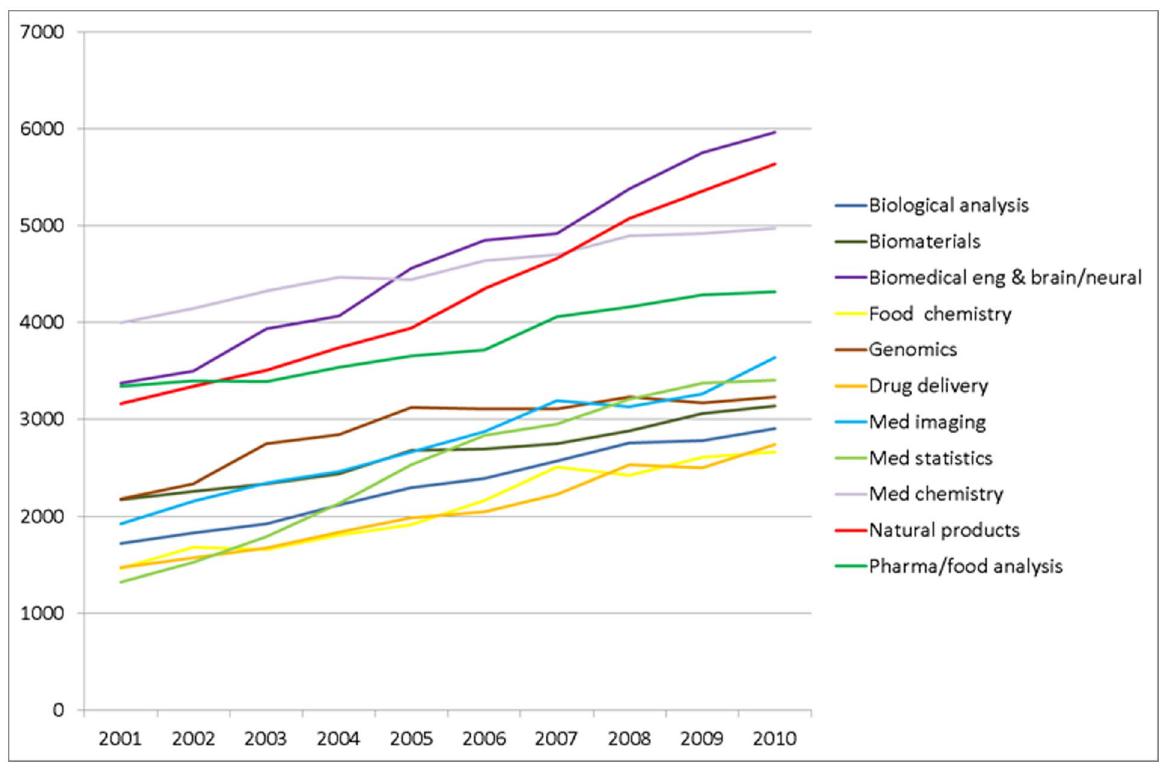
Figure 13. Term map of the Medicalstatisticsandinformatics research theme. Colors indicate the average age of the publications in which a term occurs.